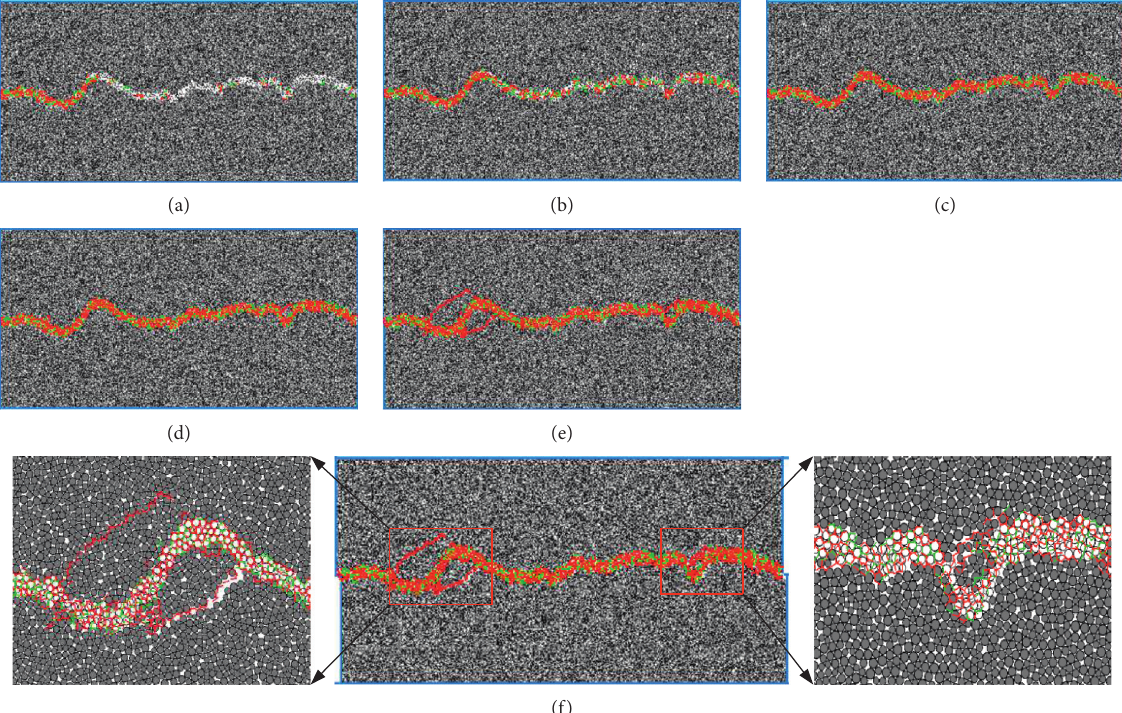
Figure 16: The development of micro-cracks of unbolted infilled rock joints: (a) 0.01mm;(b) 0.02 mm; (c) 0.05mm;(d) 0.1 mm; (e) 0.5mm; (f) 1.0